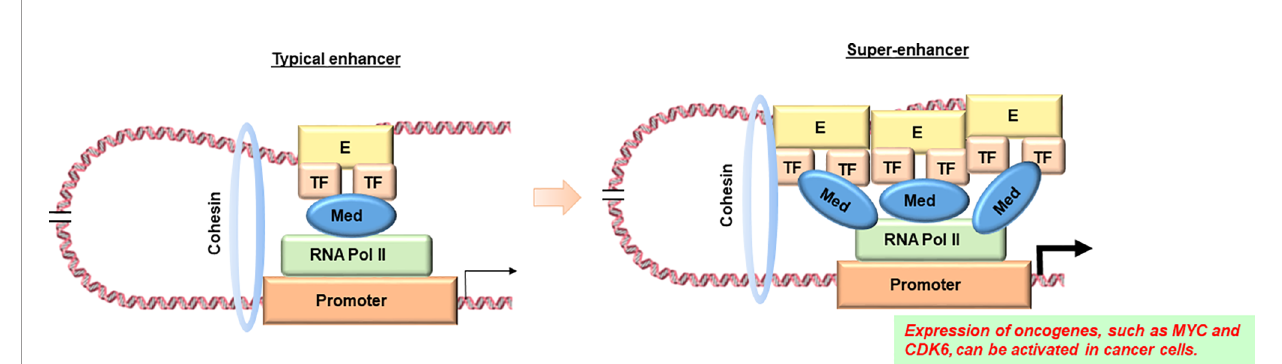
FIGURE 2 | Diagram of comparison between a typical enhancer and a super-enhancer. According to reference 87, super enhancers are observed in the transcriptional regulatory regions of oncogenes such as MYC in cancer cells, but not in their counterparts in normal tissues. E, enhancer; TF, transcription factor; Med, Mediator complex; RNA pol II, RNA polymerase II. Image credit: Shutterstock.com/ellepigra